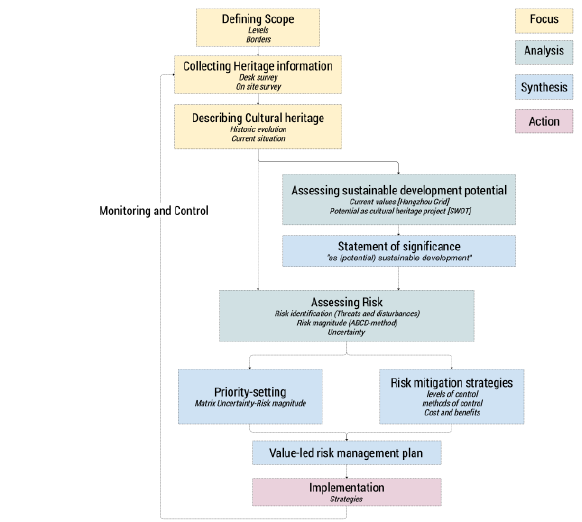
Figure 1. Proposed value-led risk management